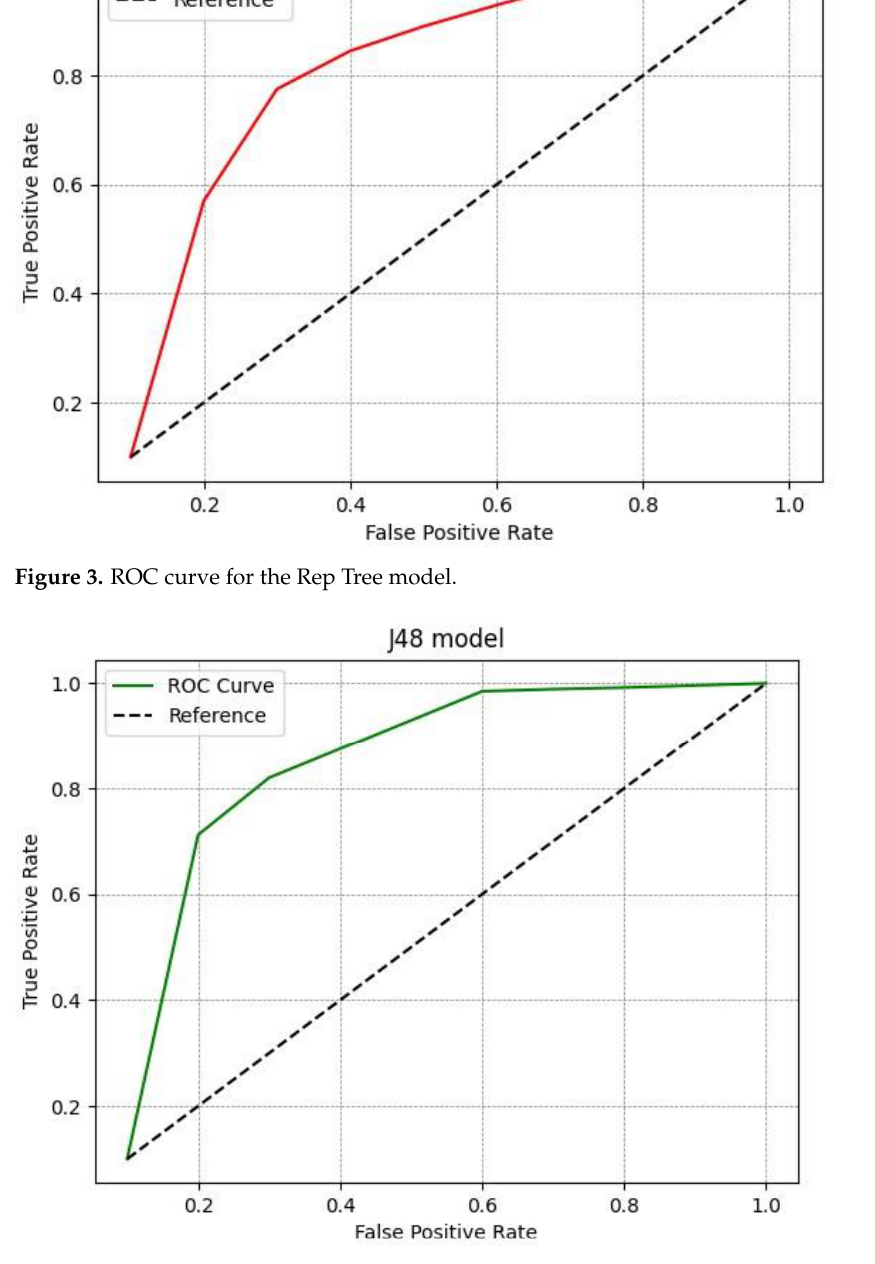
Figure 4. ROC curve for the J48 Figure 4. — ROC curve for the J48 model.